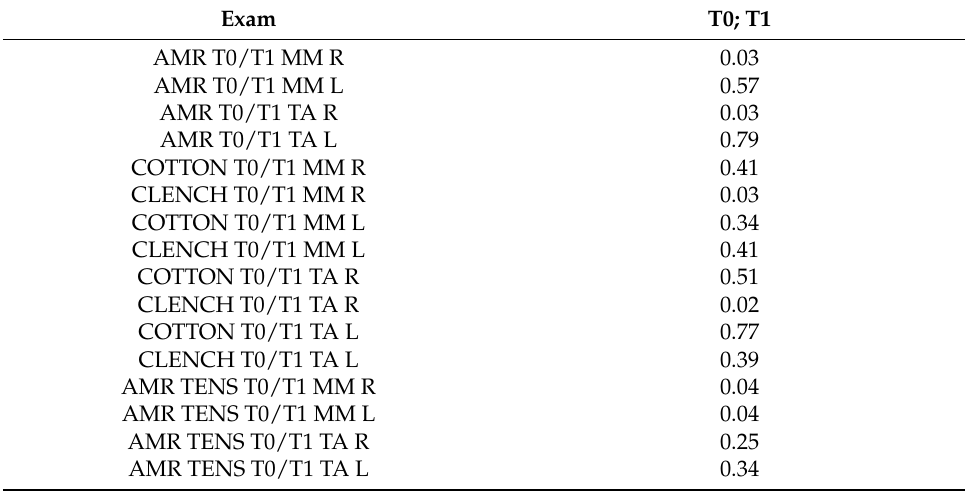
Table 2. The statistical results of the T0/T1 sessions’ comparison. Legend: MM = masseter muscle; TA = temporal muscle; L = left; R = right; T0 = pre-treatment period; T1 = post-treatment period; AMR = muscular activity at rest; AMR TENS = muscular activity at rest after transcutaneous electrical neural stimulation; COTTON = force exerted on the maximum voluntary clenching on cotton rolls; CLENCH = force exerted on the maximum voluntary clenching on